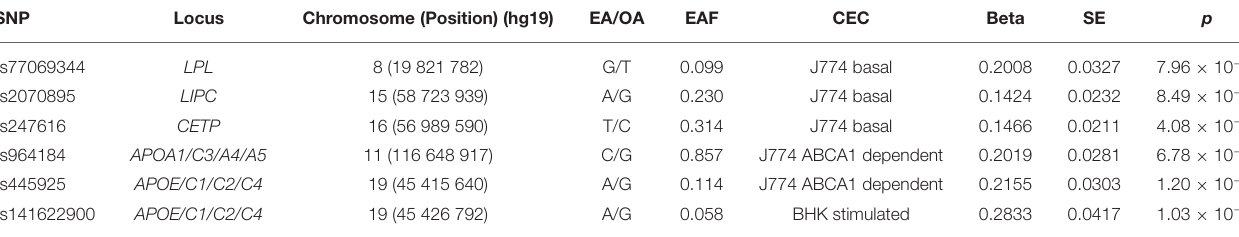
TABLE 2 | Characteristics of the included SNP loci associated with cholesterol efflux capacity. SNP Locus